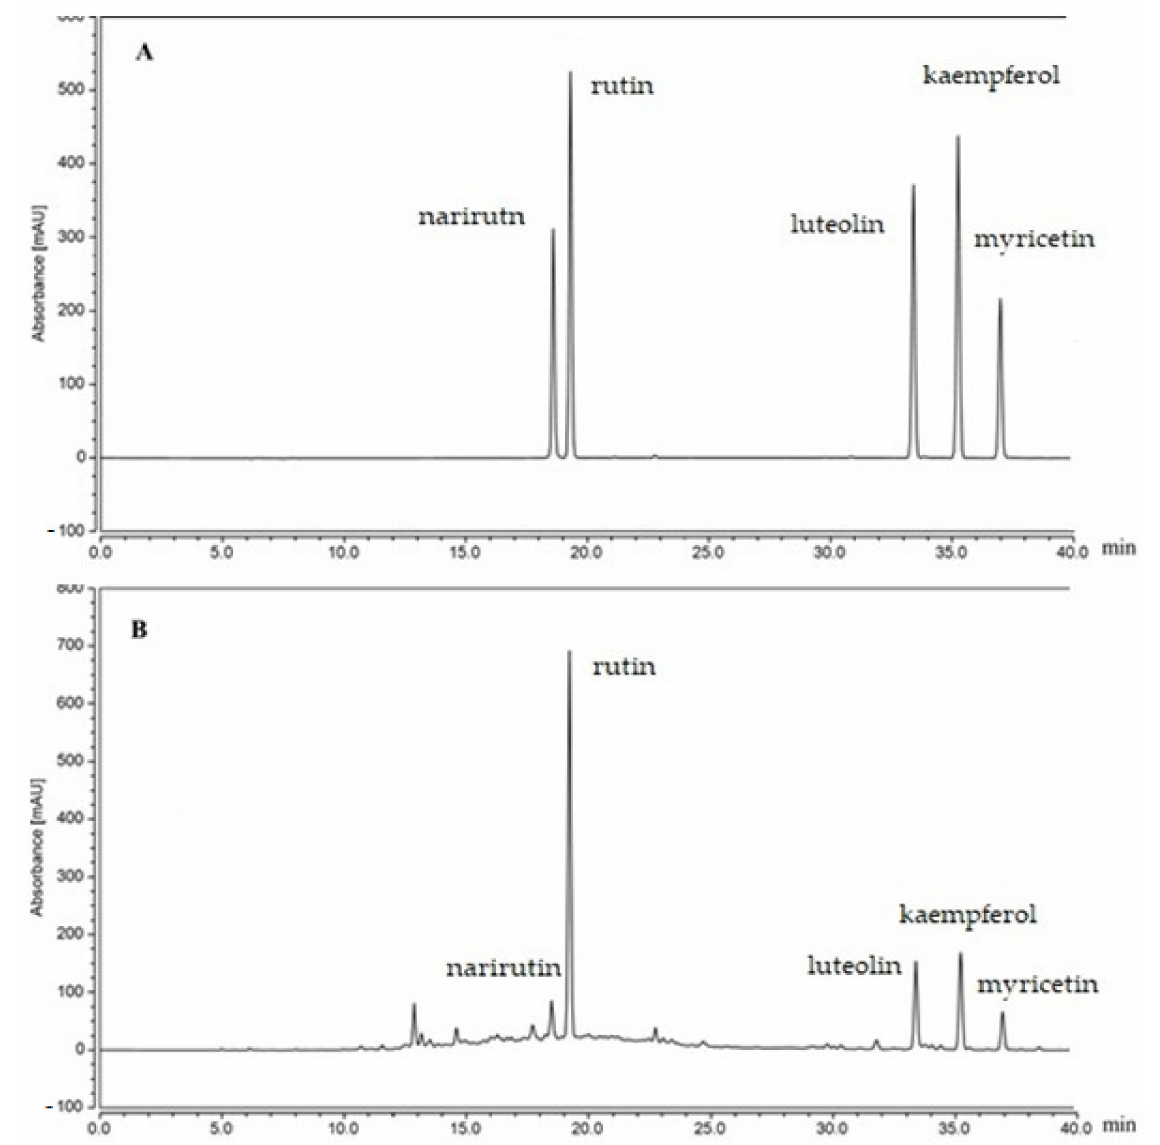
Figure 1. Chromatograms of flavonoid standards: ( A ) standard chromatograms; ( B ) flavonoid constituents of L. maritima